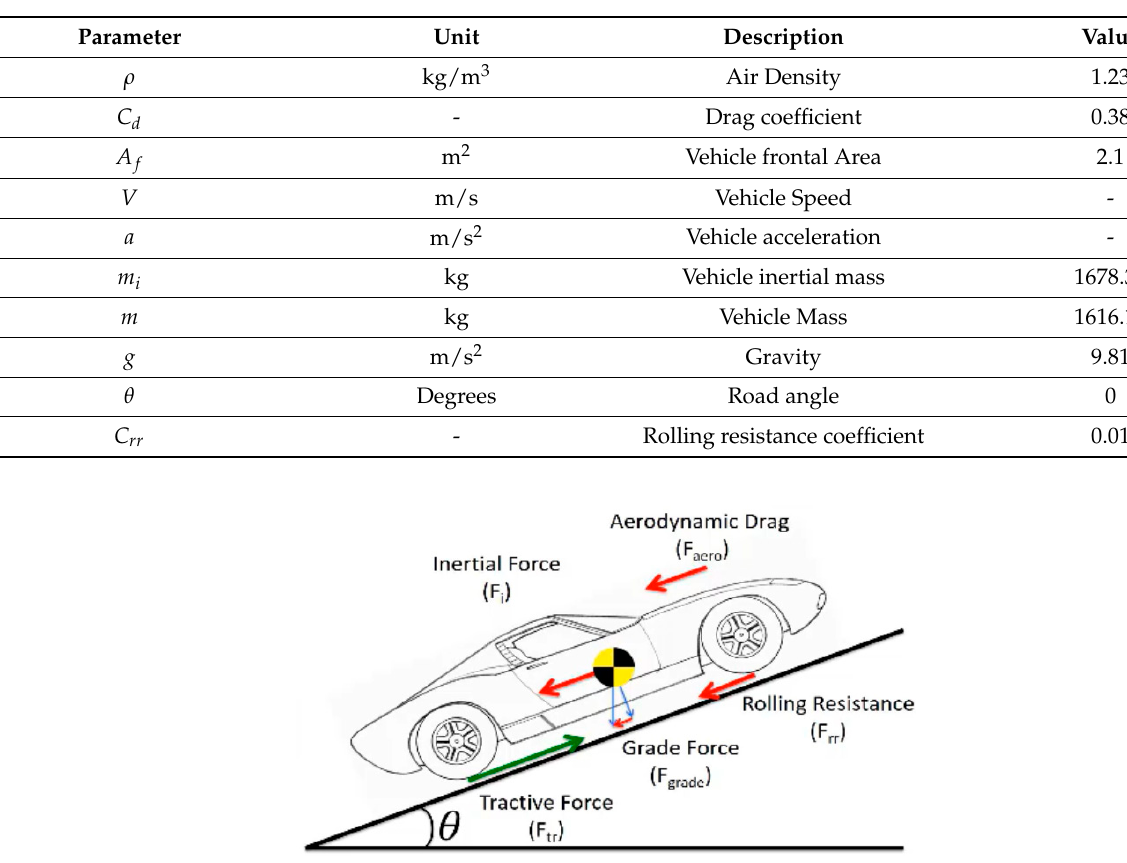
Figure 4. Simulink equation-based EV model. Adapted from [16], MathWorks: 2020. Table 2. Glider Model Parameters Adapted from [16], MathWorks: 2020.